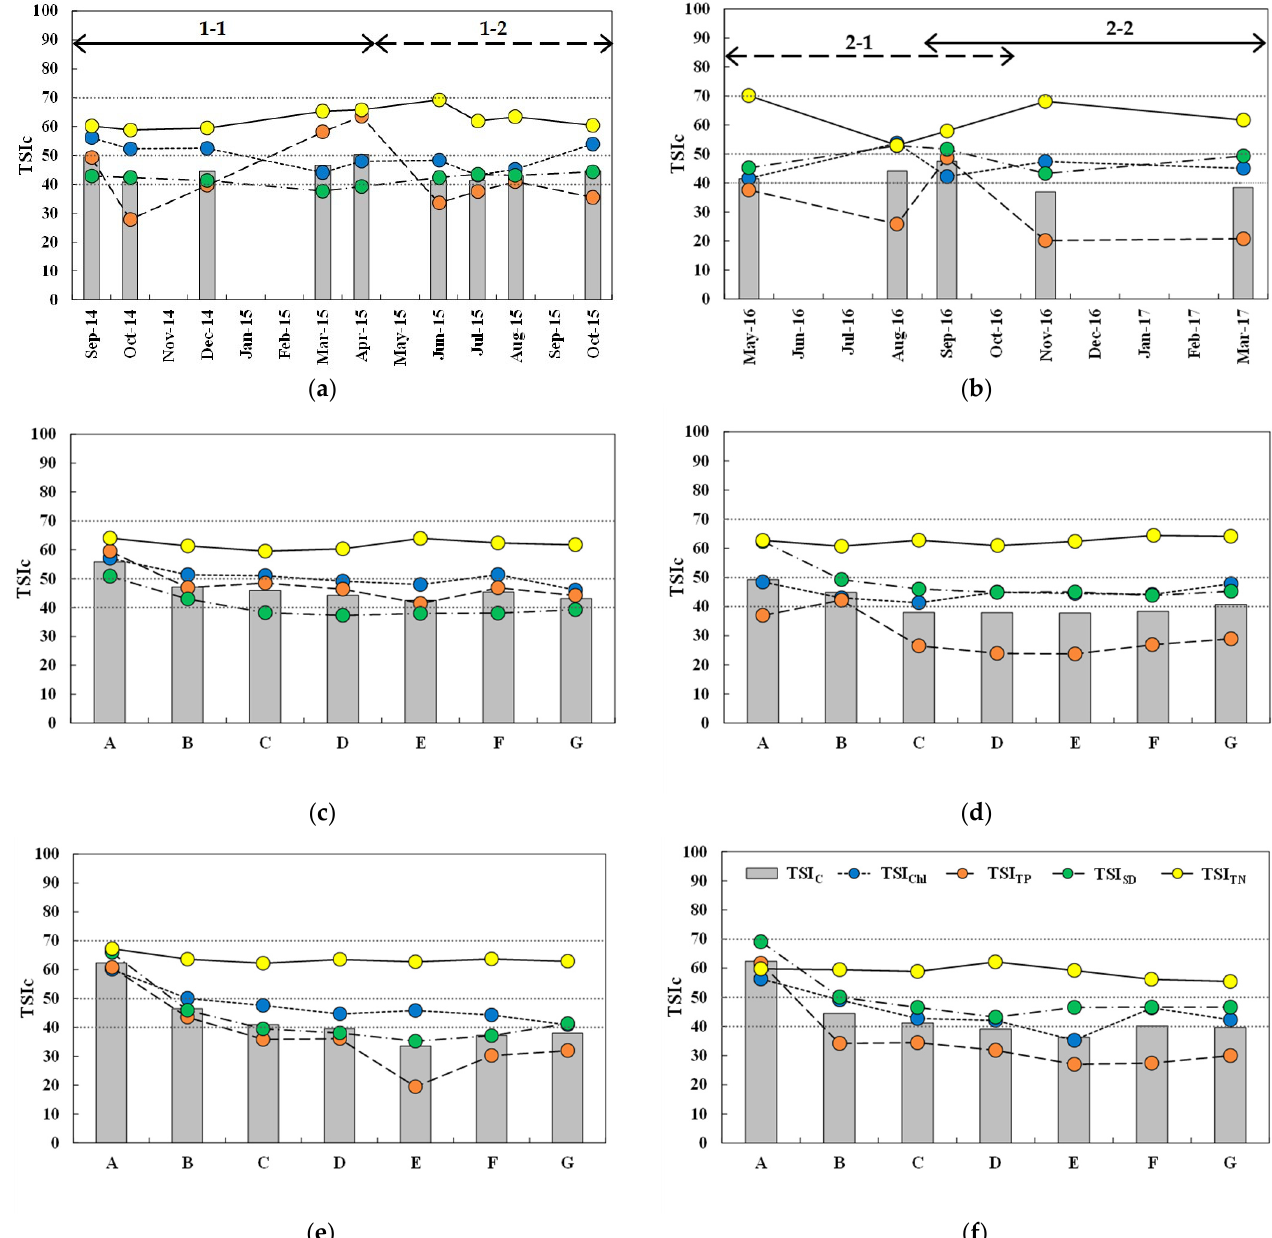
Figure 4. Variations in various trophic state indices. ( a , b ) are temporal distributions in periods 1 and 2, respectively, with subperiods indicated by double-sided arrows. ( c , d ), and ( e , f ) are corresponding spatial distributions in subperiods 1-1 and 2-2, 1-2 and 2-1, respectively.